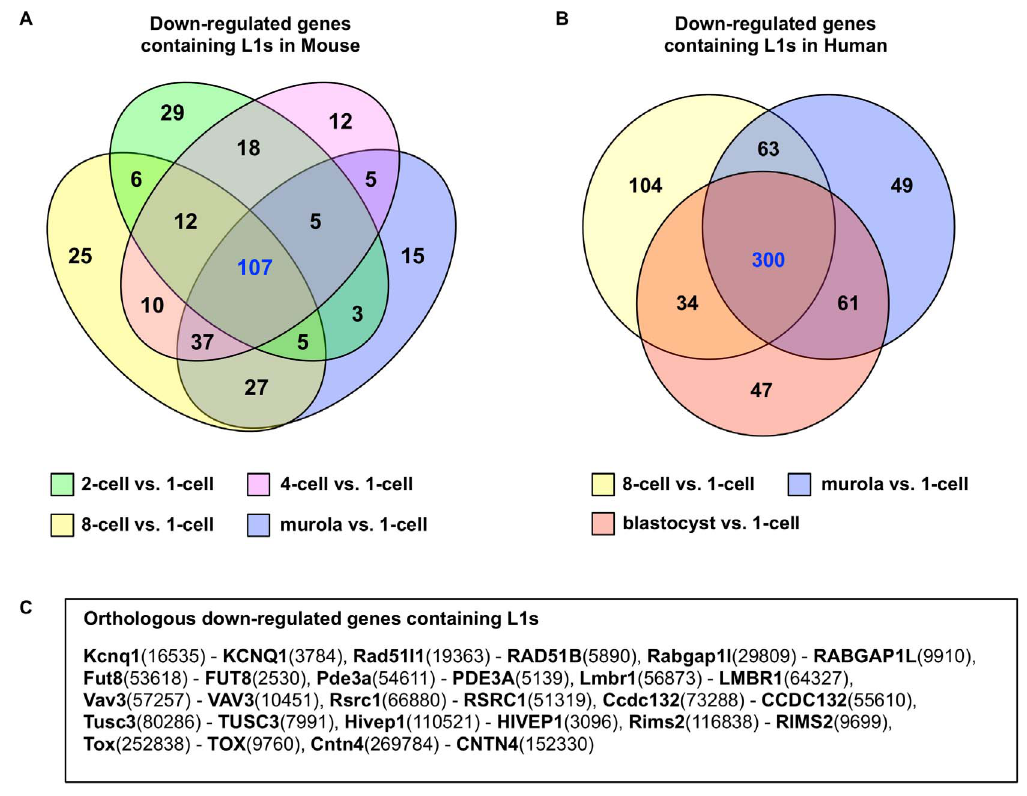
Figure 4. The down-regulated gene sets at differential gene expression stages in early embryogenesis that pass the chi-square tests. (A) Intersection of 4 gene sets in mouse genome. Each gene set is represented by a colored oval. The numbers in green, pink, yellow and blue ovals indicate the numbers of associated mouse genes in ‘‘2-cell vs. 1-cell’’, ‘‘4-cell vs. 1-cell’’, ‘‘8-cell vs. 1-cell’’, and ‘‘morula vs. 1-cell’’ differential expressions stages, respectively. (B) Intersection of 3 gene sets in human genome. A colored circle represents each gene set. The numbers in yellow, blue, and red circles indicate the numbers of associated human genes in ‘‘8-cell vs. 1-cell’’, ‘‘morula vs. 1-cell’’, and ‘‘blastocyst vs. 1-cell’’ differential expression stages, respectively. (C) Name listing of mouse-human orthologous genes found in both mouse and human intersection gene sets. Each orthologous gene pair indicates the mouse gene name followed by the human gene name. The numbers in parentheses present the corresponding gene ids.